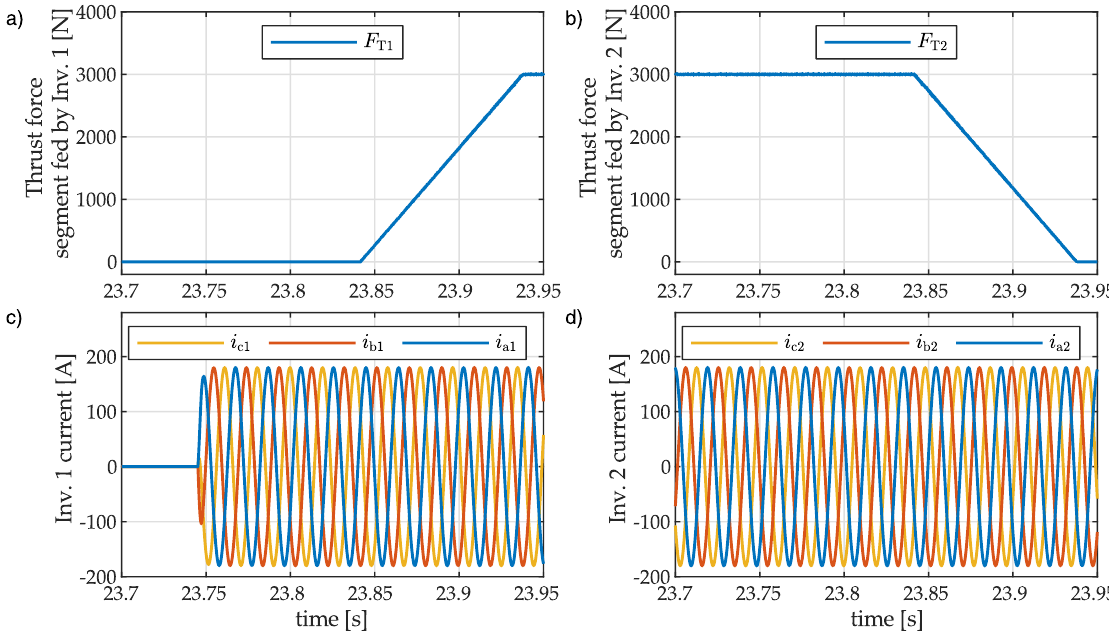
Figure 14. Thrust genereation during vehicle movement at the stator segment-to-segment connection—simulation results. ( a ) thrust generated by the stator fed by inverter 1, ( b ) thrust generated by the stator fed by inverter 2, ( c ) phase current of inverter 1, ( d ) phase current of inverter